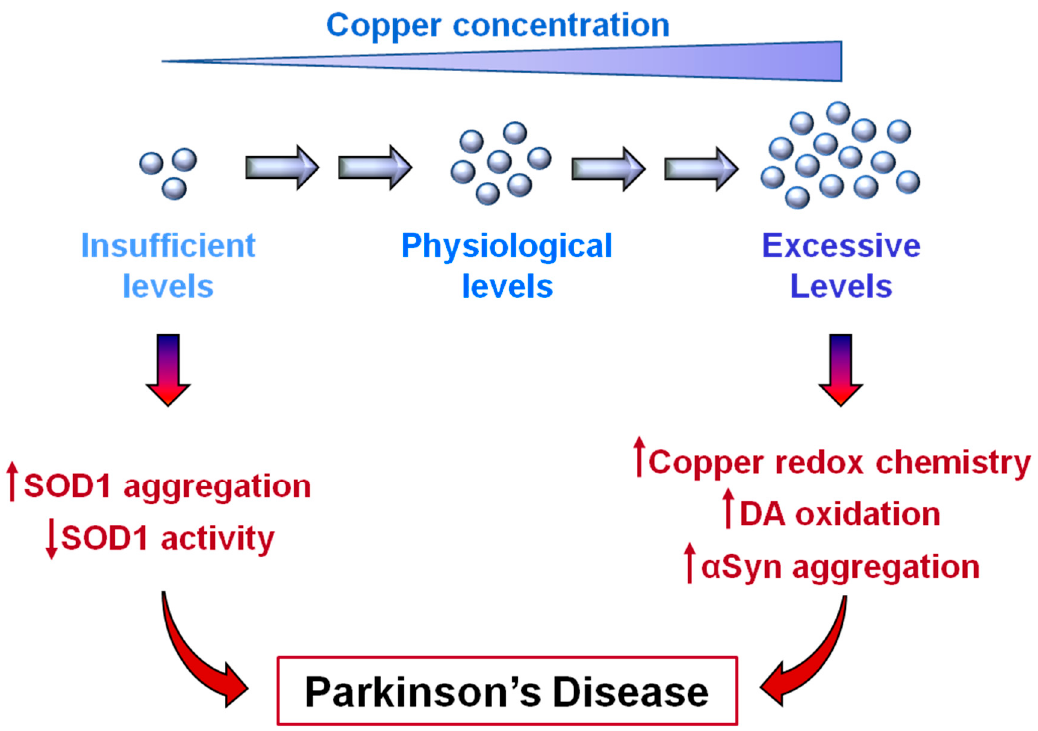
Figure 4. Copper dishomeostasis in Parkinson’s disease (PD). Copper deficiency, as well as excessive copper levels, can promote cellular events associated with PD. Low levels of copper are responsible for SOD1 aggregation while hindering SOD1 maturation. High levels of copper promote α -synuclein aggregation and increase oxidative conditions through Fenton and Haber–Weiss reactions and by favoring dopamine (DA) oxidation.